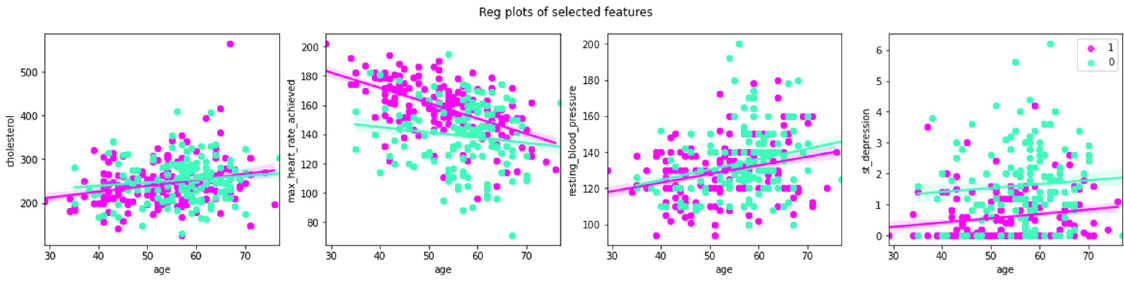
Figure 9. Regression plots of selected features.